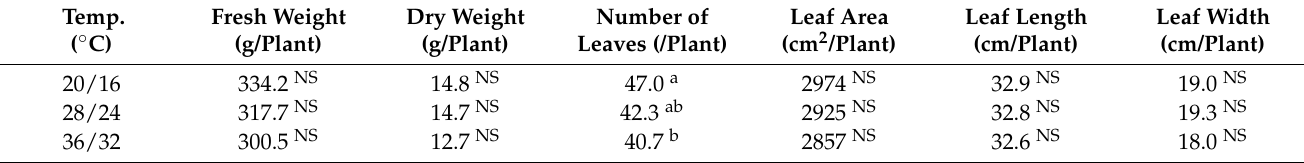
nificant differences among different groups (Bonferroni correction test). Table 1. Average values of major growth parameters of Chinese cabbage grown at 20 ◦ C, 28 ◦ C, and Table 2. Photosynthetic characteristics of Chinese cabbage grown at 20 °C, 28 °C, and 36 °C for eight 36 ◦ C for eight days. days.